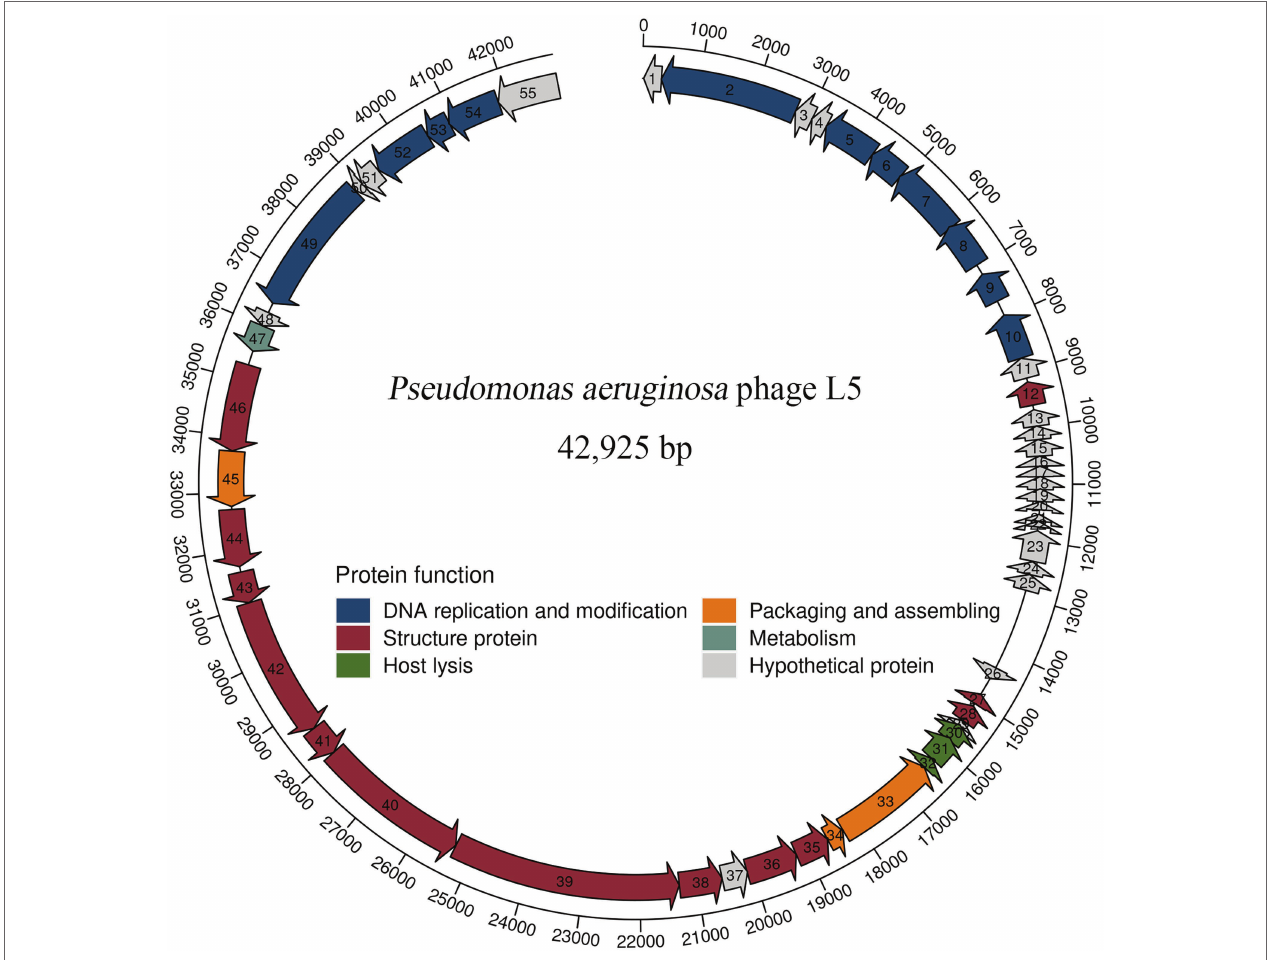
FIGURE 2 | Genome organization of P. aeruginosa phage L5. Arrows represent predicted CDSs, with the direction of the arrow indicating the transcription direction. The different colors indicate different functional modules of gene products. The L5 genome can be divided into six functional